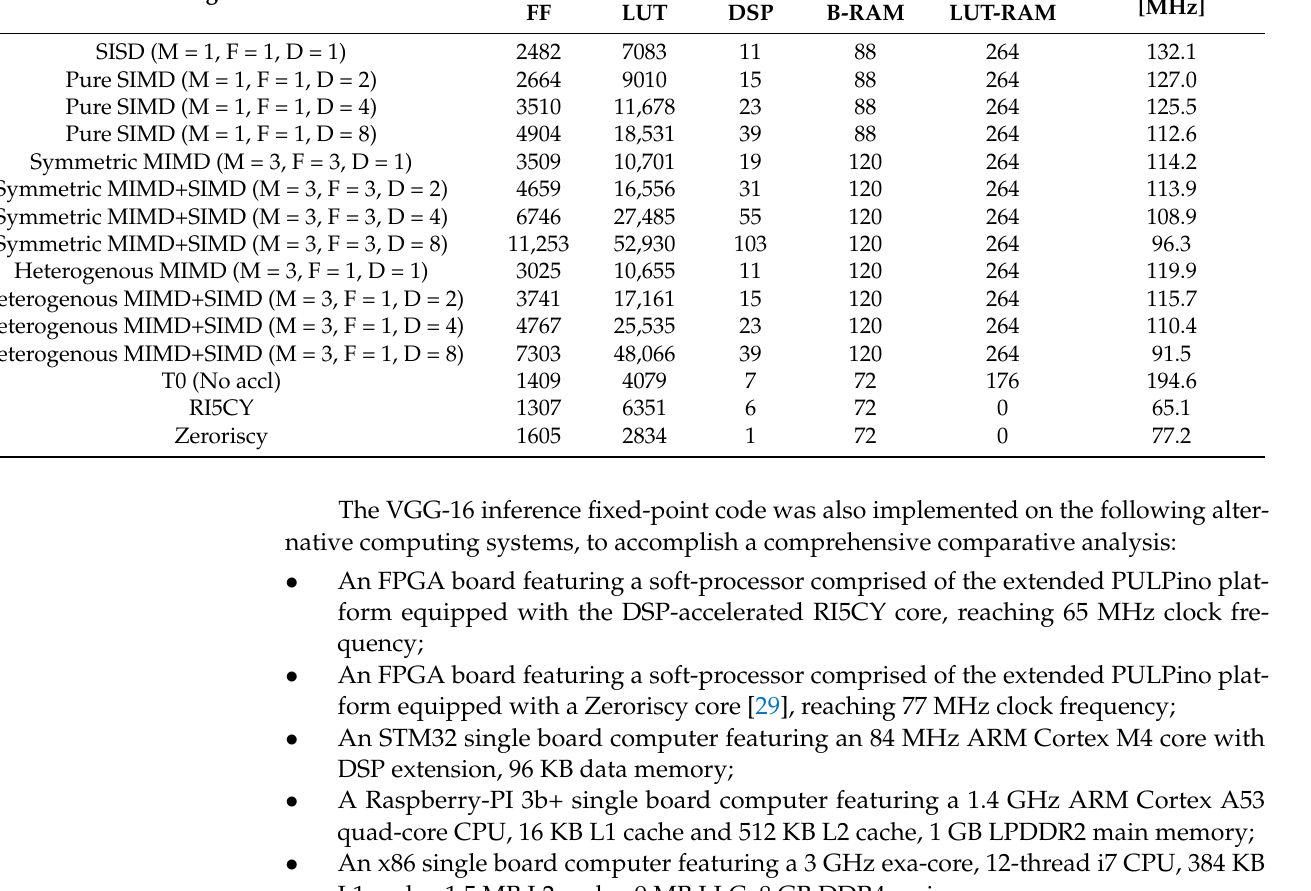
Table 4. Area and frequency summary of the Klessydra-T cores equipped with to 1 MB Data Mem. Configuration